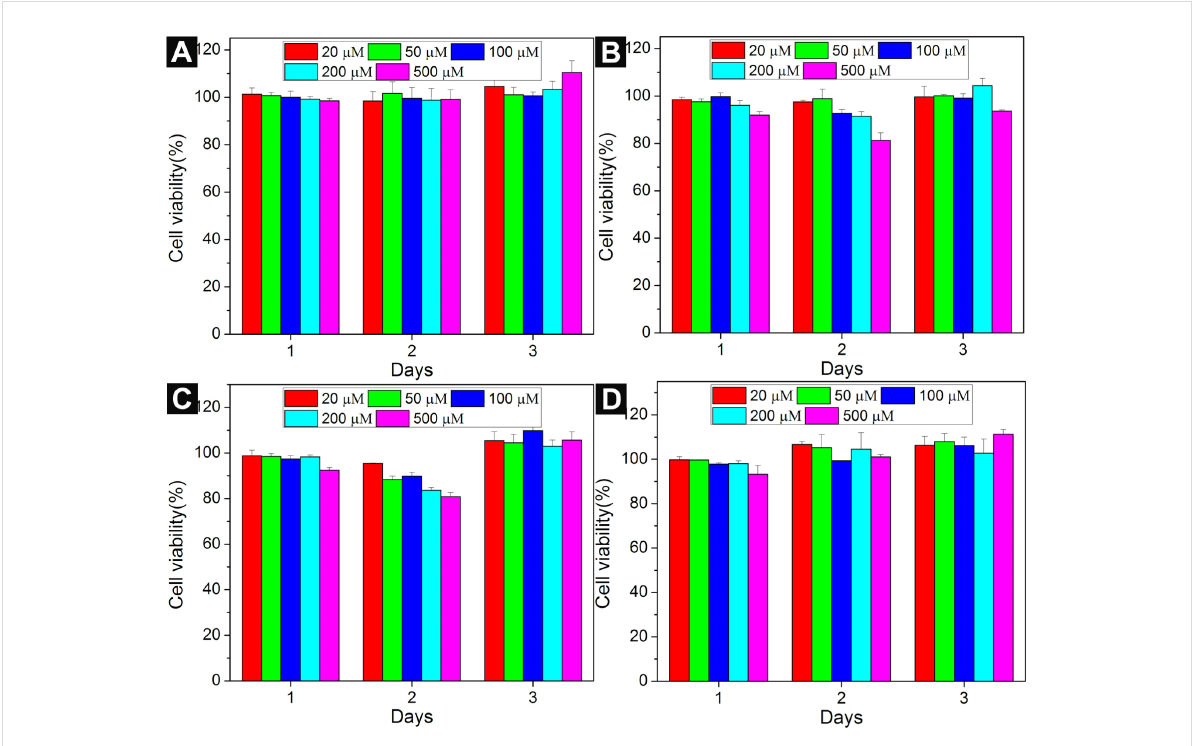
Figure 2: Cell viability of HeLa cells incubated with (A) 1 , (B) 2 , (c) 5 , (D) 6 at different concentrations for 3 days.